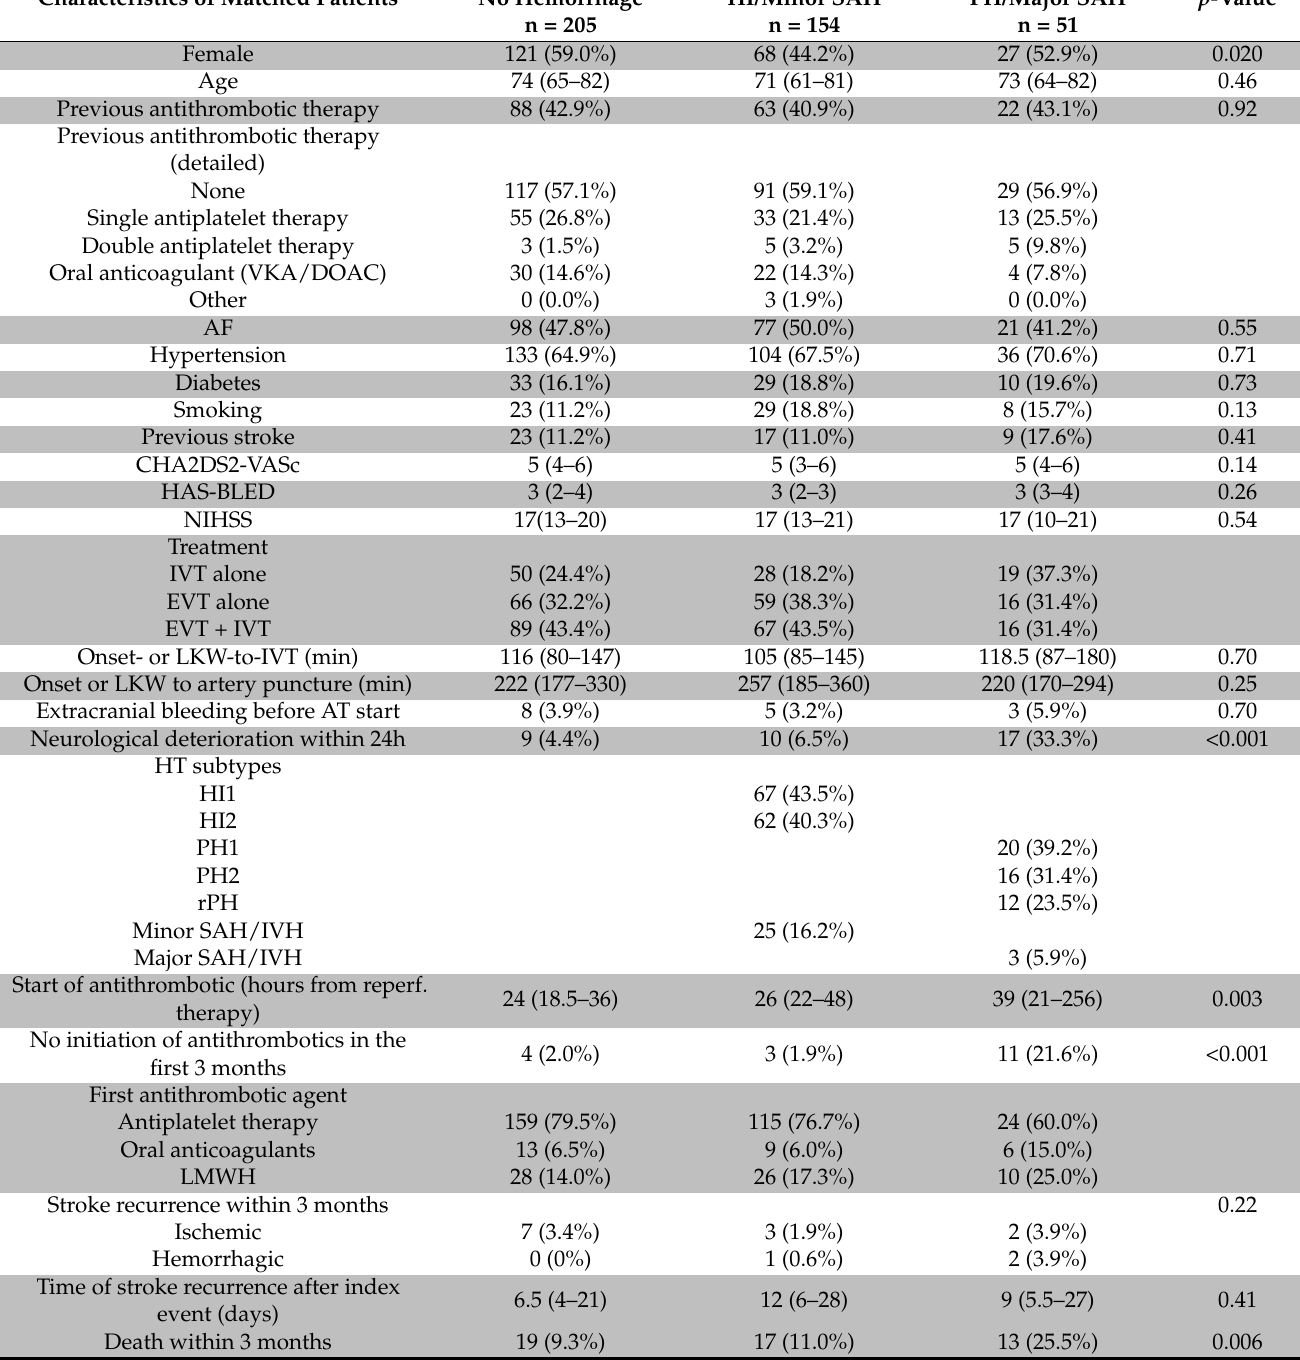
Table 3. Comparison of no hemorrhage group vs. minor hemorrhage group vs. major hemorrhage group regarding baseline characteristics and outcomes after